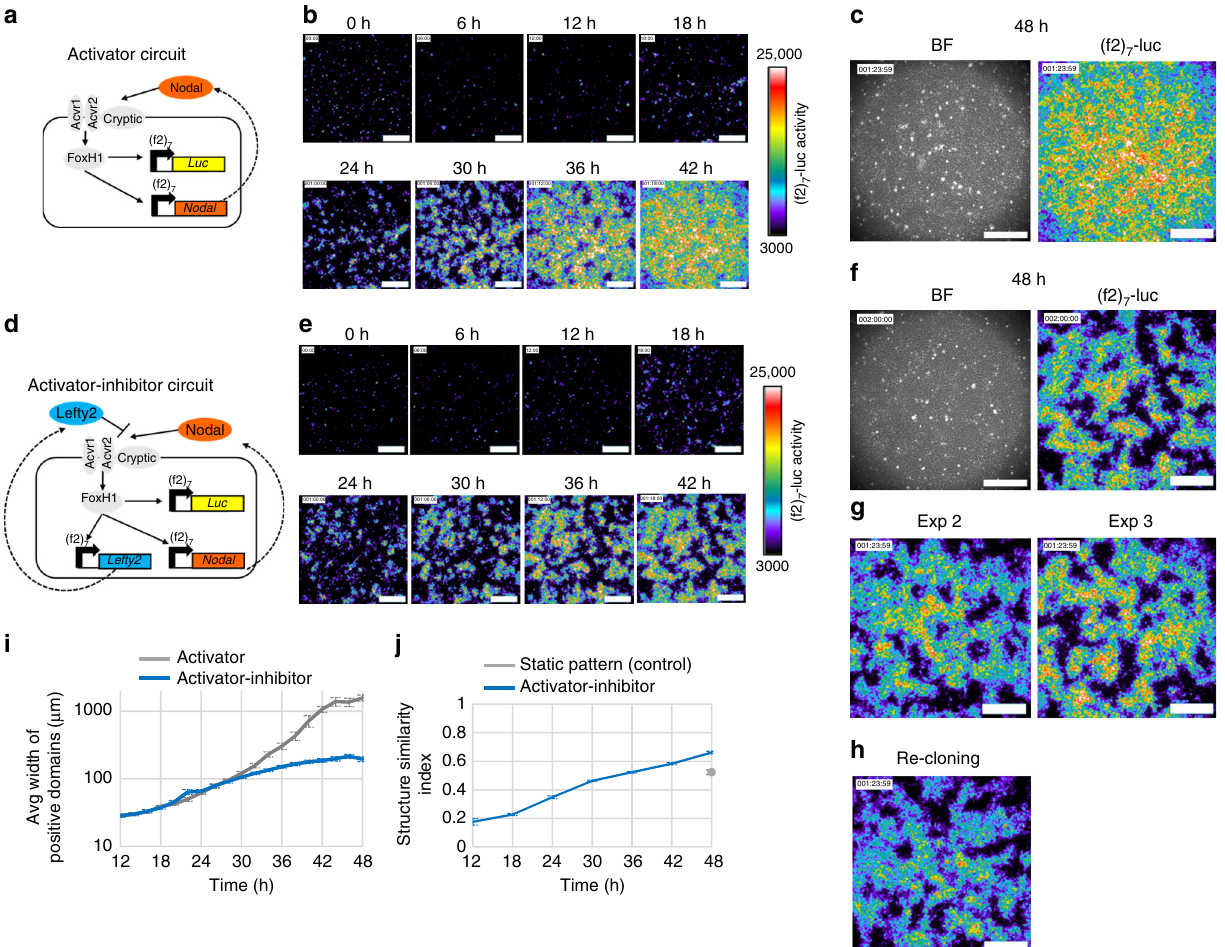
Fig. 1 Cells with an activator – inhibitor circuit spontaneously give rise to a pattern. a The activator circuit. b Time-lapse imaging of the HEK293 cells engineered with the activator circuit. See also Supplementary Movie 1. c The bright fi eld and luciferase images of the cells with the activator circuit at 48 h. d The activator – inhibitor circuit. e Time-lapse imaging of the HEK293 cells engineered with the activator-inhibitor circuit. See also Supplementary Movie 1. f The bright fi eld and luciferase images of the cells with the activator – inhibitor circuit at 48 h. g Repeated experiments of f . h The luciferase image of an activator-inhibitor cell line at 48 h that was re-cloned from the cells shown in f . i The width of positive domains was measured at each time point as described in Supplementary Fig. 3. j The structural similarity (SSIM) index between two images at time t and t + 6 h was calculated as described in Supplementary Fig. 3. A higher index means a more stable pattern. The gray dot at 48 h indicates the SSIM index of a control static sample, where the cells that constitutively express luciferase were mixed with wild-type cells. Scale bars: 400 μ m ( b , c , e – h ). Source data are provided as a Source Data fi le ( i , j